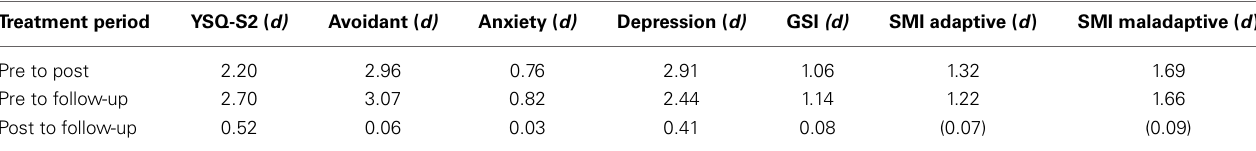
Table 4 | Effect sizes ( d) in all questionnaire measures, showing both pre to post effects and pre to follow-up effects. Treatment